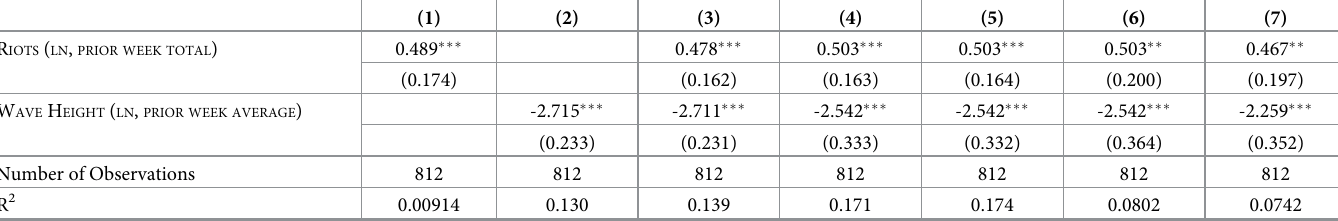
Table 1. Riots, sea conditions, and migrant flows to